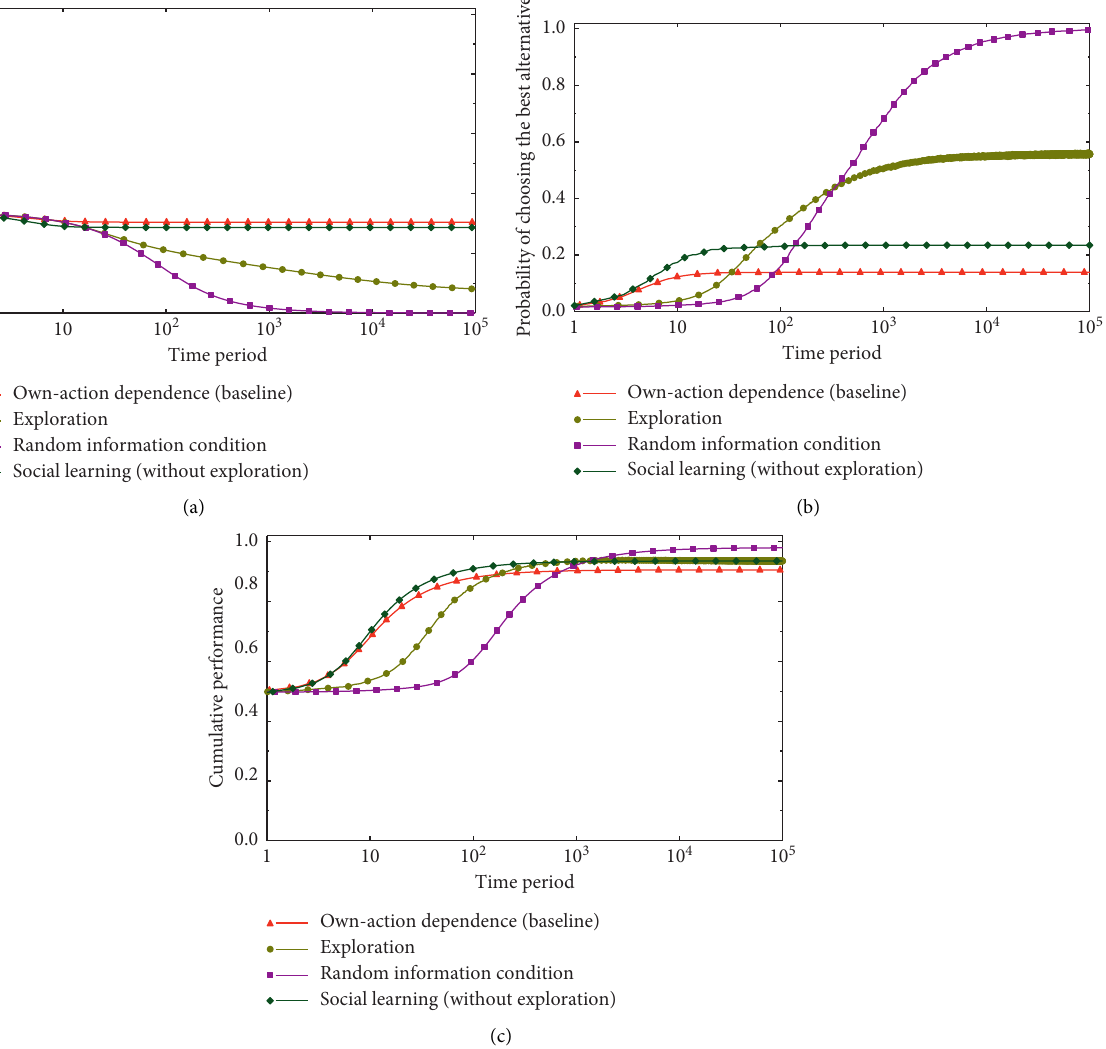
Figure 2: Self-confirming biased beliefs for different correcting mechanisms. (a) Degree of biased beliefs (i.e., the distance between belief and reality), (b) probability of choosing the best alternative, and (c) cumulative performance (divided by time period).